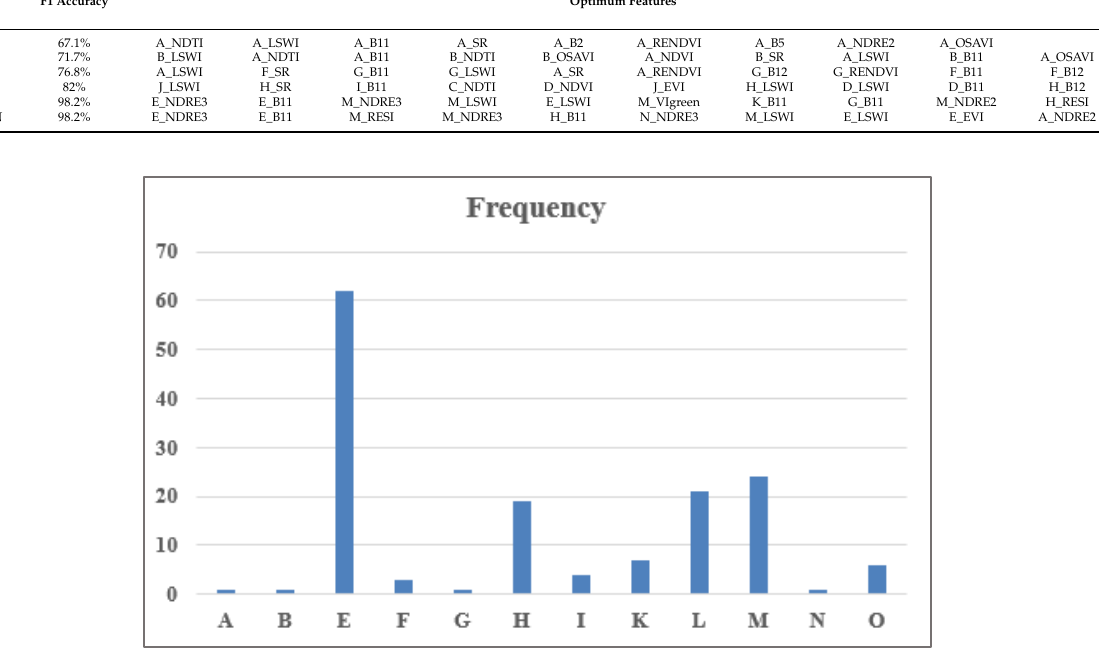
Figure 11. Frequency of the key change temporal on 7 July 2020.